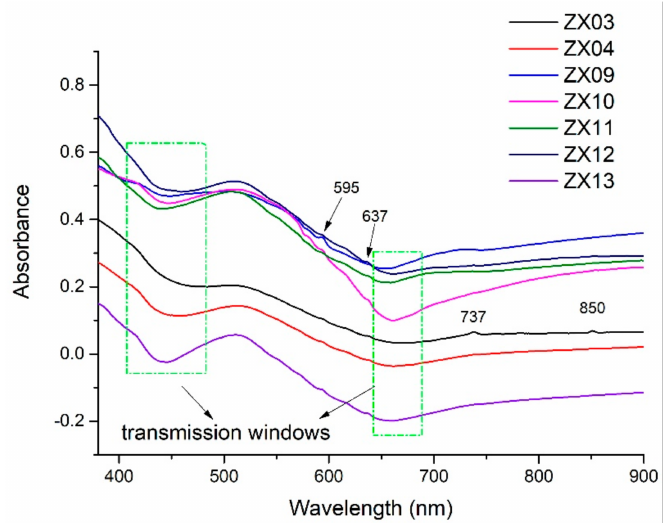
Figure 6. UV-Vis-NIR spectra of these CVD synthetic diamonds show strong absorption due to the NV centre. In addition, defects such as 595 nm were